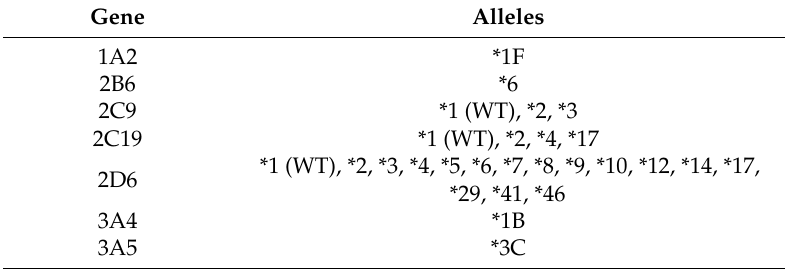
Table 5. Pharmacogenetic testing. Genes and alleles included in the study.